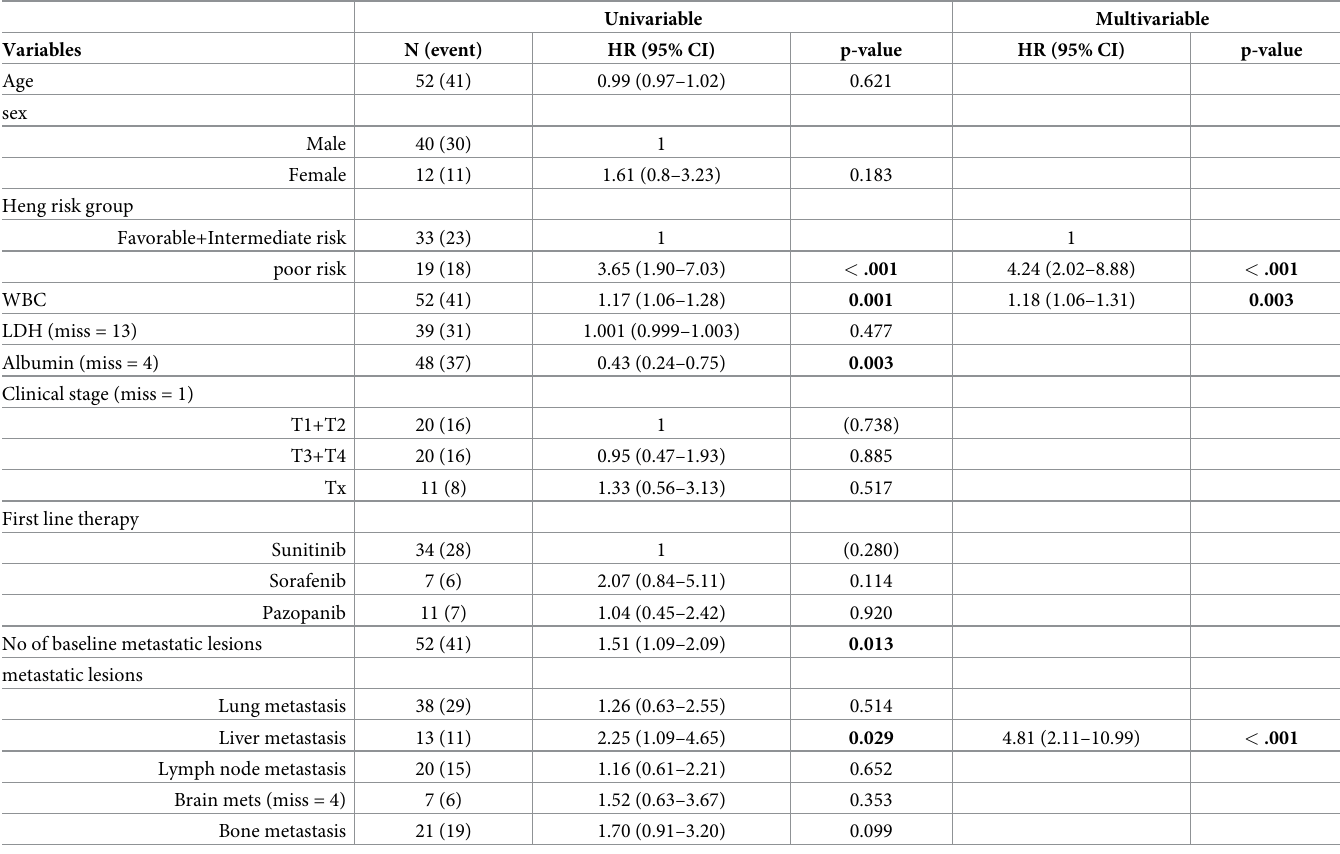
Table 5. Cox regression analysis of the prognostic factors for overall survival in treated TKI only patients